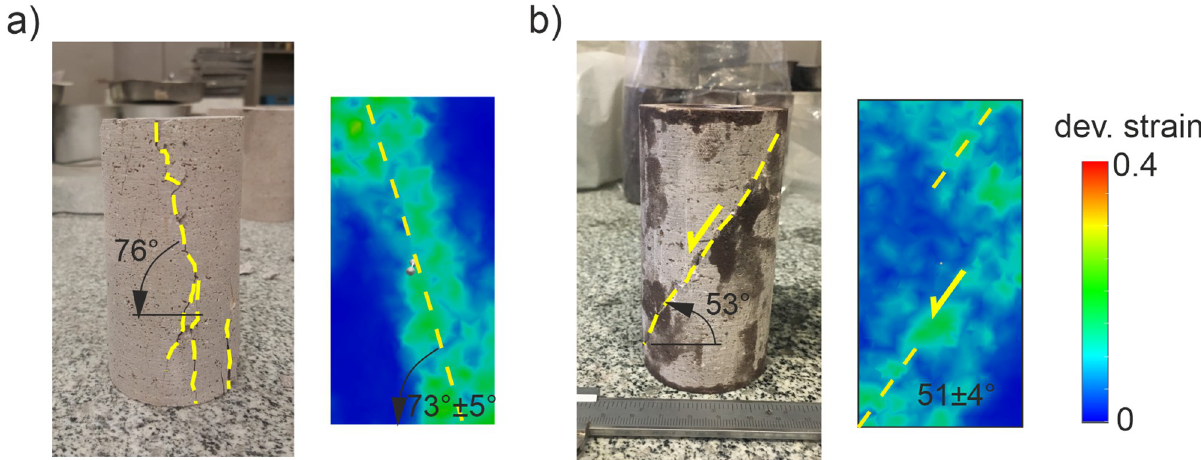
Fig 4. Macro-cracks in the laboratory samples (left) and strain field patterns in DEM model samples (right) after failure (a) Under uniaxial compressive loading condition (b) Under triaxial compressive loading ( σ